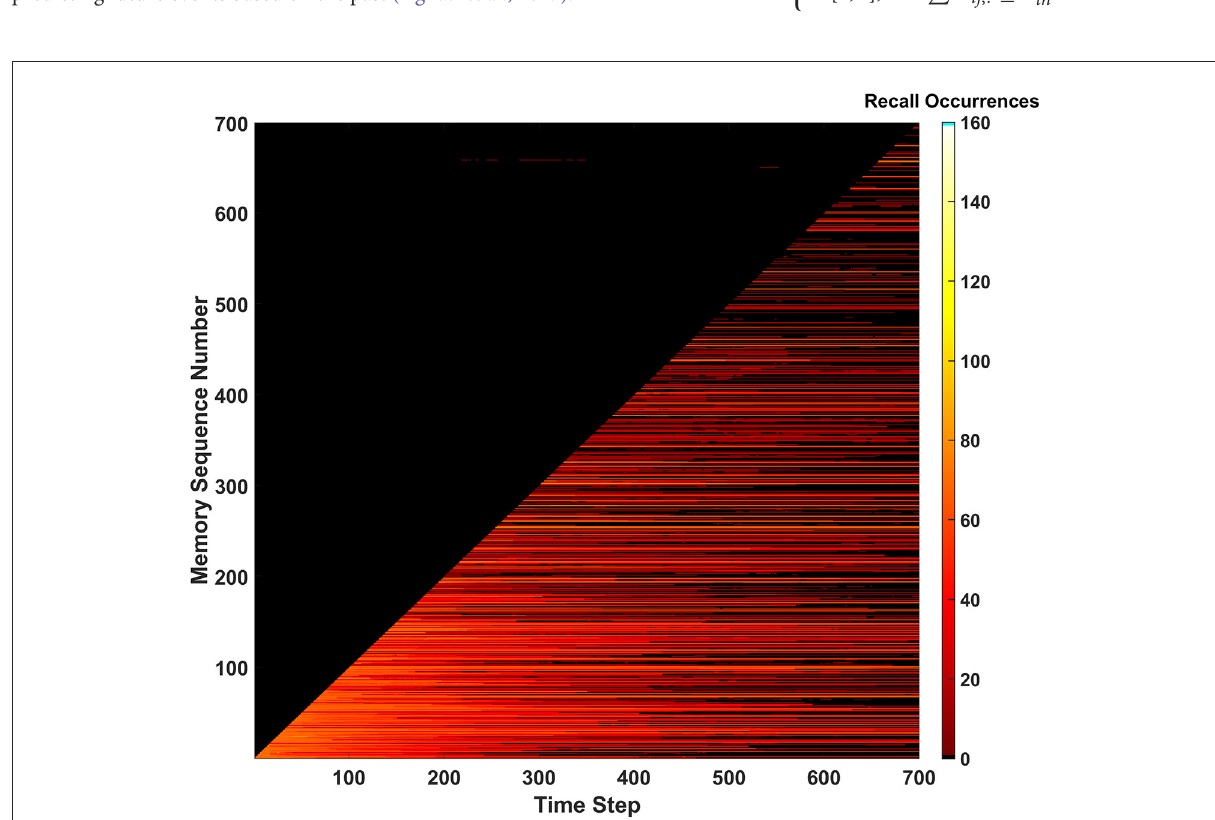
FIGURE7 Recall occurrences heatmap for the predictive behavior when P th = 6 v ON . An increased amount of successful predictions were not seen, and the frequency of permanently unrecallable memories sharply increases as the simulation approaches its end due to the synaptic grid